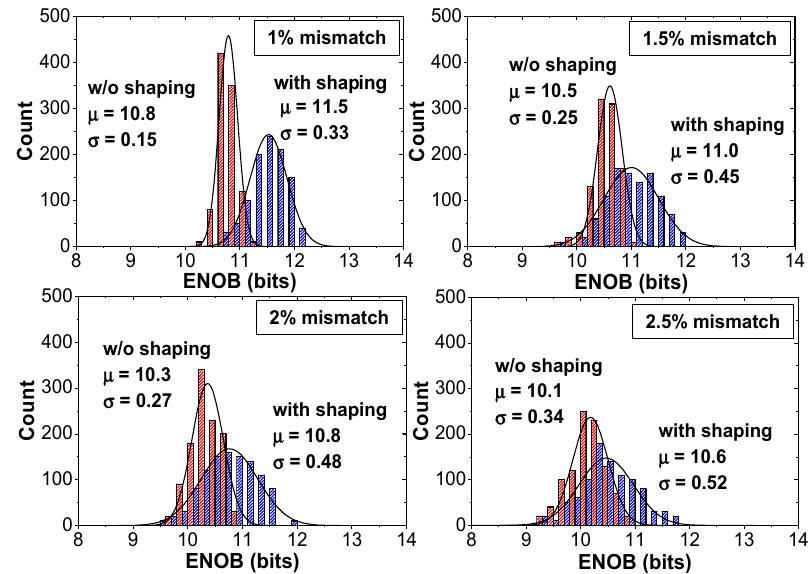
Figure 9. Probability distributions of the ENOB for different CDAC mismatch rate.